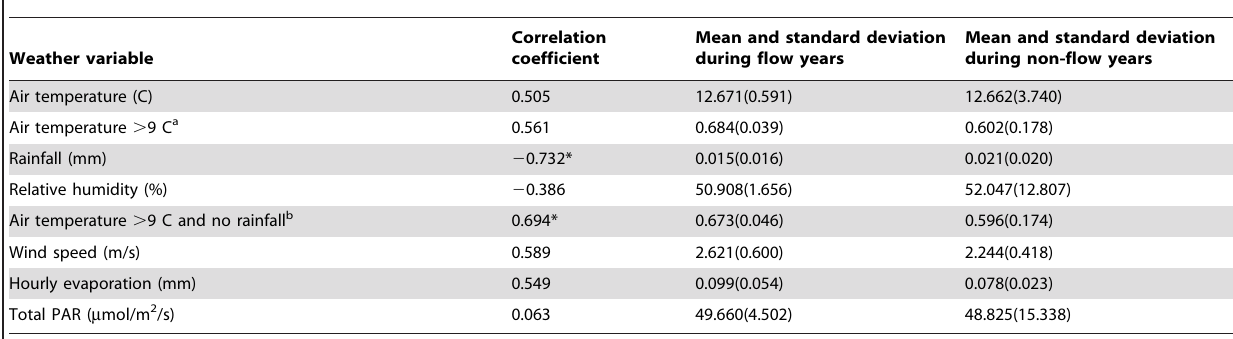
Table 3. Correlation coefficient between weather variables and the proportion of trees surveyed [excluding trees in the transgenic plot (T0)] with GUS positive seeds for 7 years (2004–2010) with mean and standard deviation of each weather variable during years where gene flow was observed (2006, 2007, 2008) or was not observed (2004, 2005, 2009,